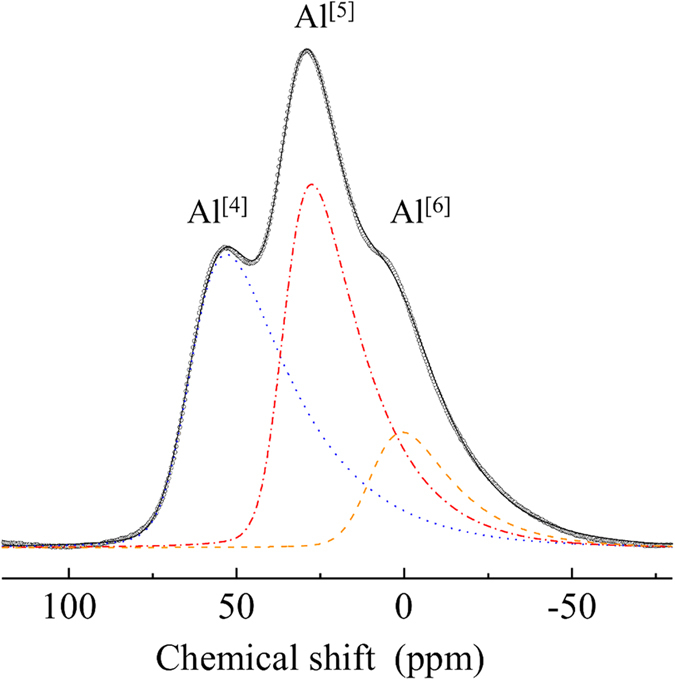
27Al MAS NMR spectrum of the 54Al2O3-46Ta2O5 glass.The total fitting curve corresponds to the sum of three Czjzek fitting curves: blue dots (Al[4]), red dashes and dots (Al[5]), and orange dashes (Al[6]).